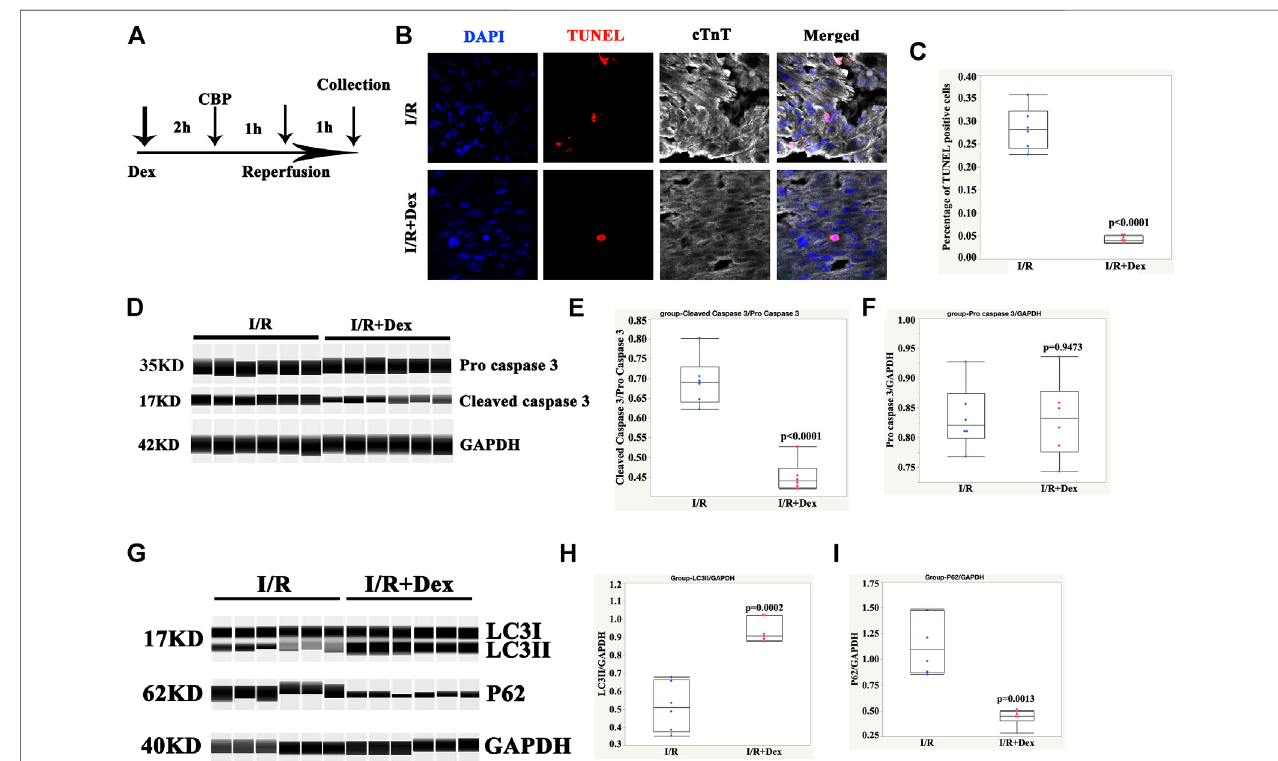
FIGURE1| Dexprotectedhumanventricular tissuefrom apoptosisand wasassociatedwithautophagy. (A) Timelines oftheDex, cardiopulmonarybypass(CBP), and reperfusion treatments. (B) Representative immuno fl uorescence images of the ventricular tissues pretreated with Dex and the control tissues. Blue (DAPI), red (TUNEL), and white (cTnT). (C) Quanti fi cation of the TUNEL positive cells. N (cid:2) 6 patients, ten slides/patient. (D) Representative pro-cleaved caspase 3 Wes blot of atrial tissues pretreated with Dex. (E) Quanti fi cation of the cleaved caspase 3 relative expression. N (cid:2) 6 patients. (F) Quanti fi cation of the pro-caspase 3